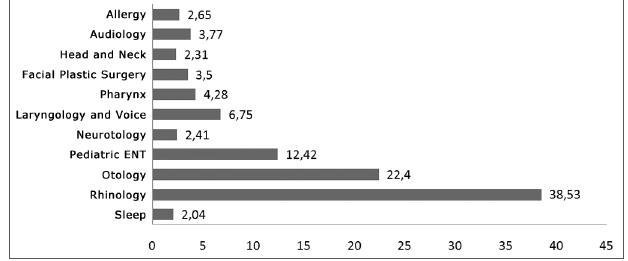
of Bahia Figure 1. Working field (2007 census from the ABORLCCF)